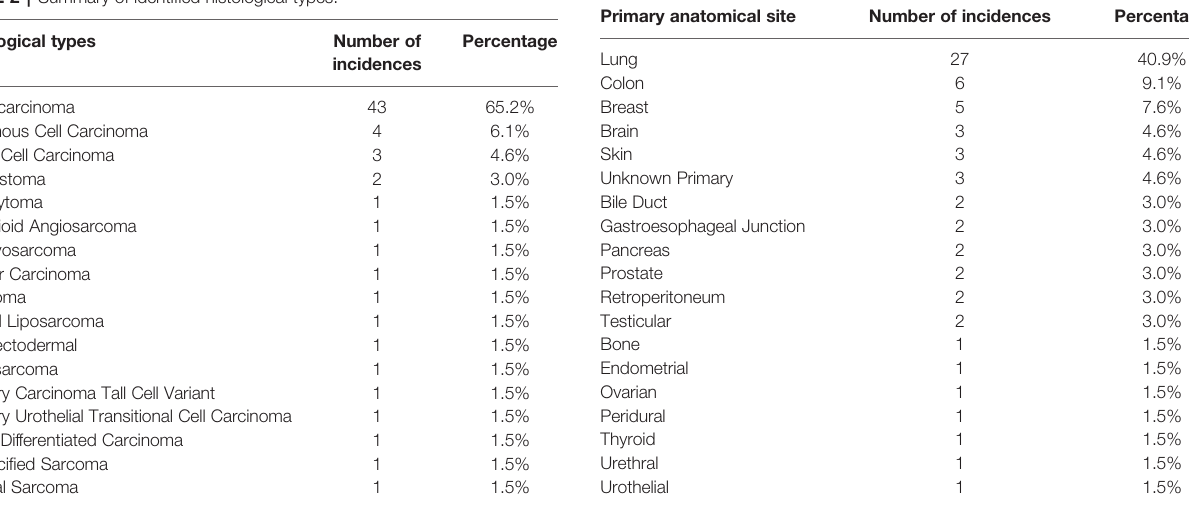
TABLE 2 | Summary of identi fi ed histological types.